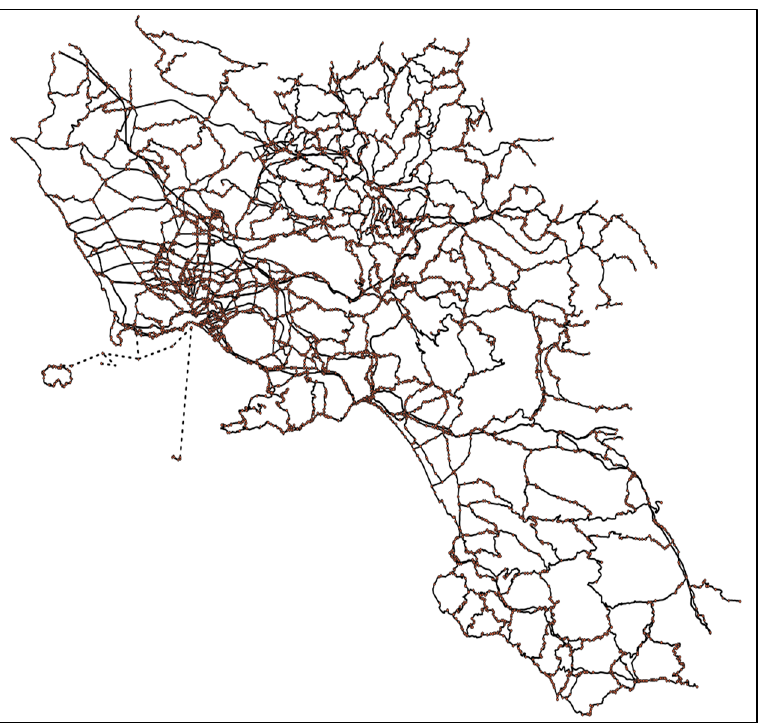
Figure 10. OD matrix scheme.